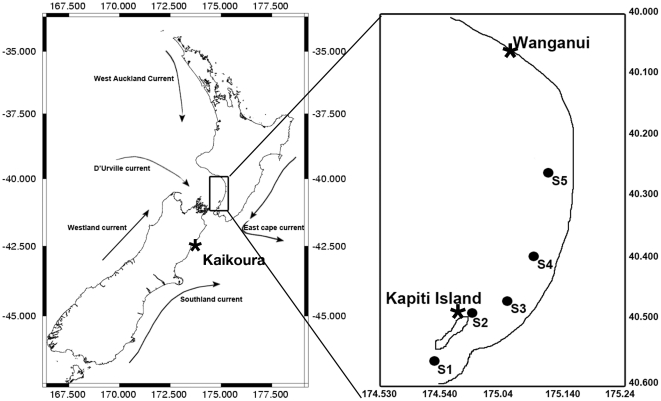
Map showing coast where artificial islands were deployed.